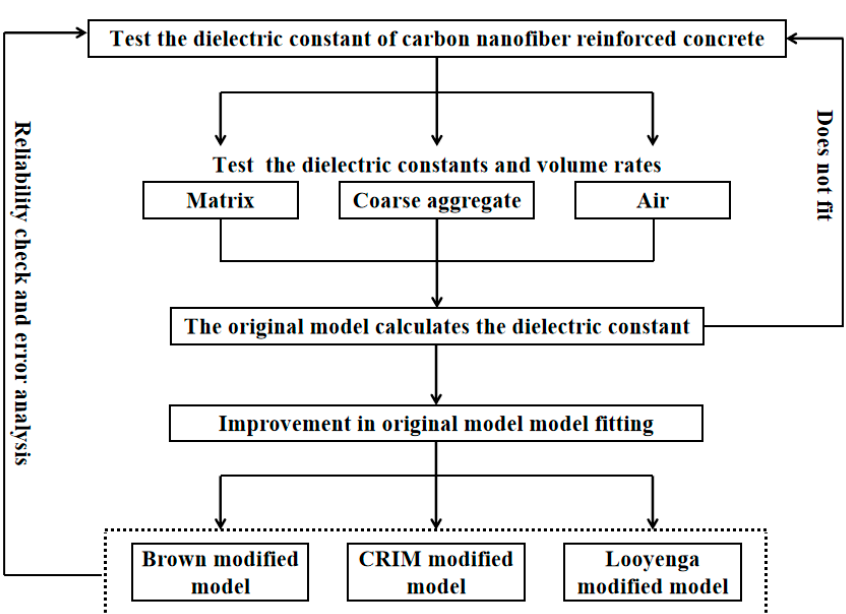
Figure 3. Test protocol flow chart.